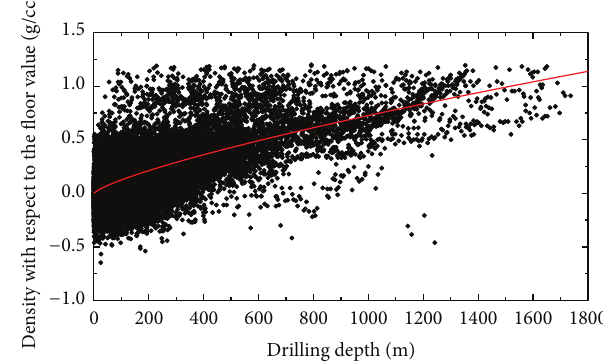
Figure 5: Relation between the (residual) marine sediment density and the sediment depth. The residual density values were calculated relative to a theoretical (upper layer) density ̃𝜌 0 (1). Theoretical density values (red line) were calculated using the expression in